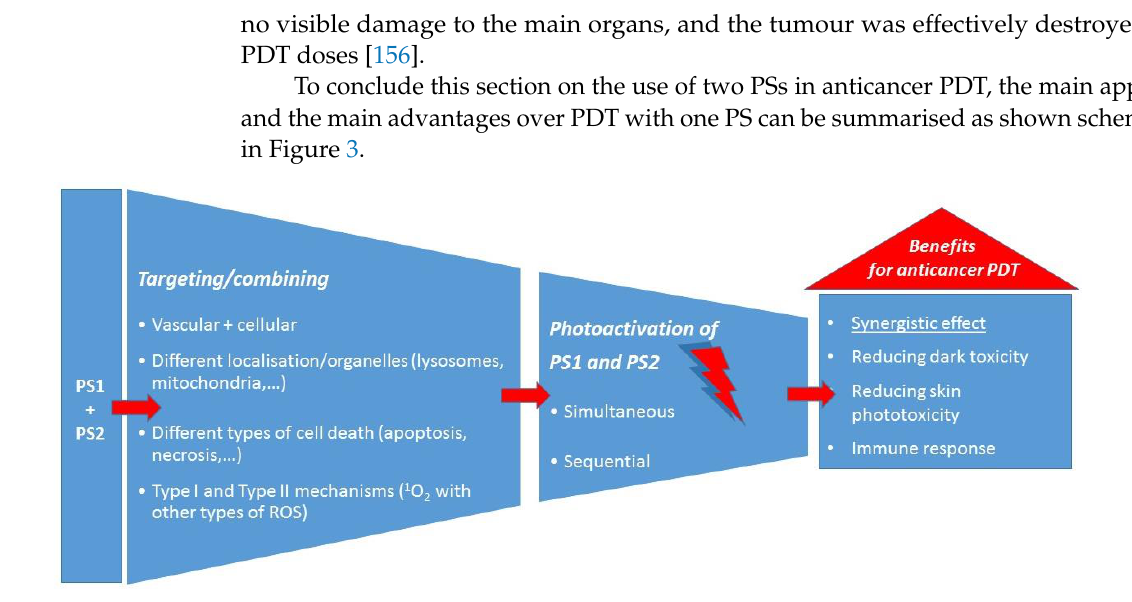
Figure 3. The main approaches in the use of two PSs for anticancer PDT and the main benefits.